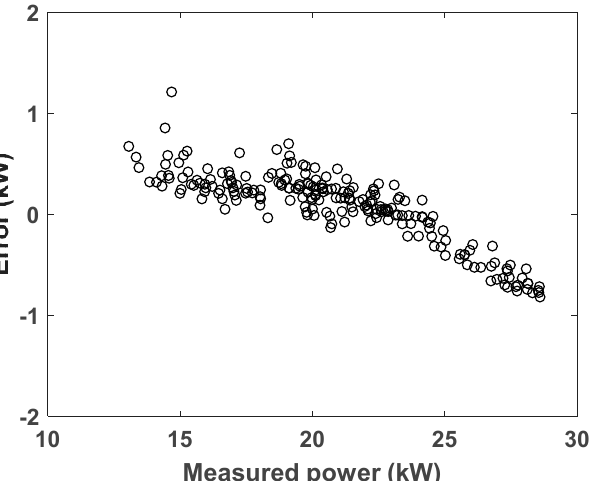
Figure 5. Analysis of the homoscedasticity of the errors of the calibrated model for the powers.